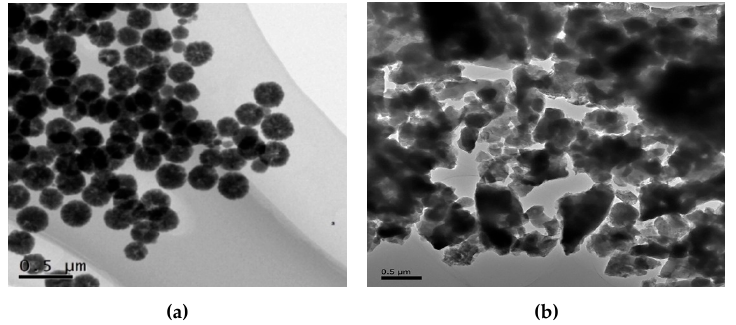
Figure 4. TEM of adsorbents, ( a ) uncoated Fe 3 O 4 and ( b ) Fe 3 O 4 @mZrO 2 -Re (Re = Y/La/Ce).